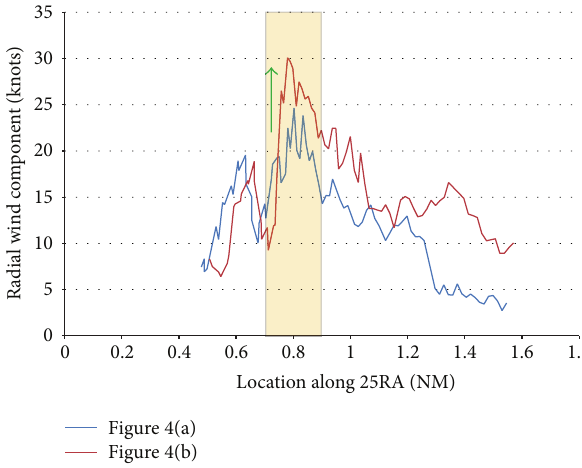
Figure 5: Profile of radial wind component measured by short- range LIDAR along glide path of corridor 25RA during the winds- hear event shown in Figure 4. Blue line corresponds to the top panel of Figure 4 and red line the middle panel. The rapid surge in radial velocity associated with the pilot windshear report is highlighted.